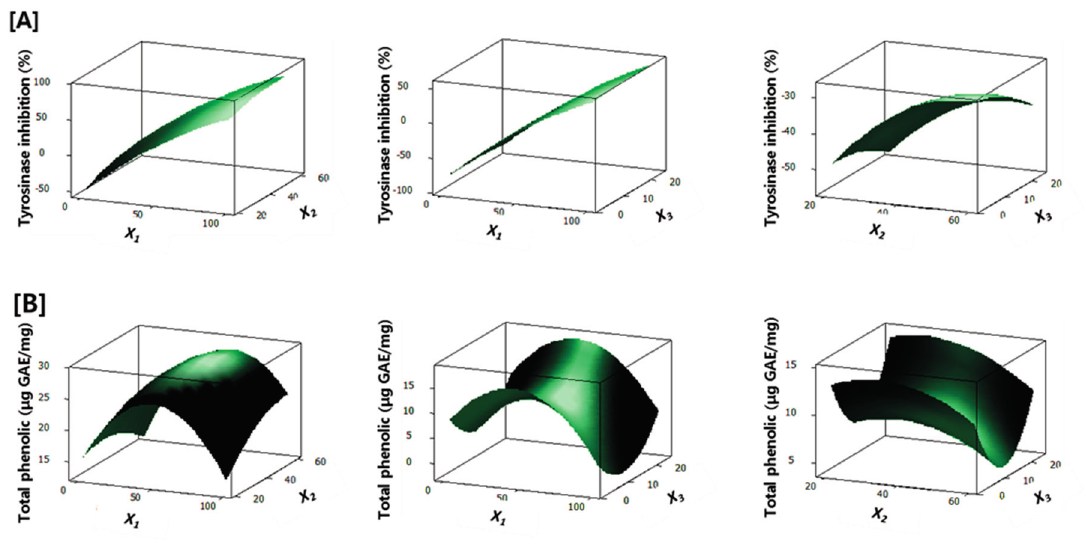
Figure 3. Response surface plots show the effect of extraction variables on ( A ) tyrosinase inhibition and ( B ) total phenolic content. Three variables are methanol concentration ( X 1 ), extraction temperature ( X 2 ) and extraction time ( X 3